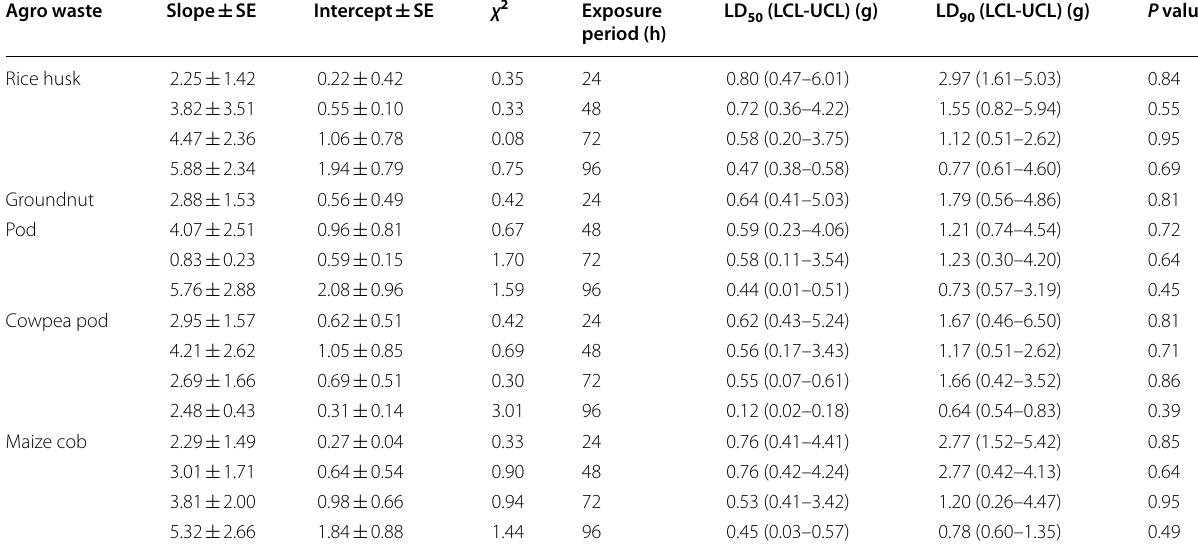
χ 2 Chi-square value, SE standard error, LCL lower confidence limit, UCL upper confidence limit